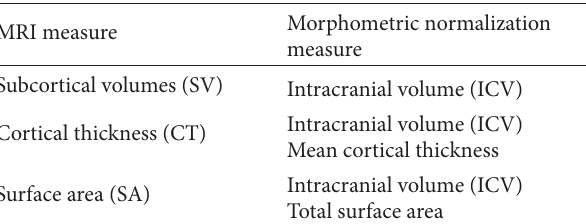
Table 2: Normalization